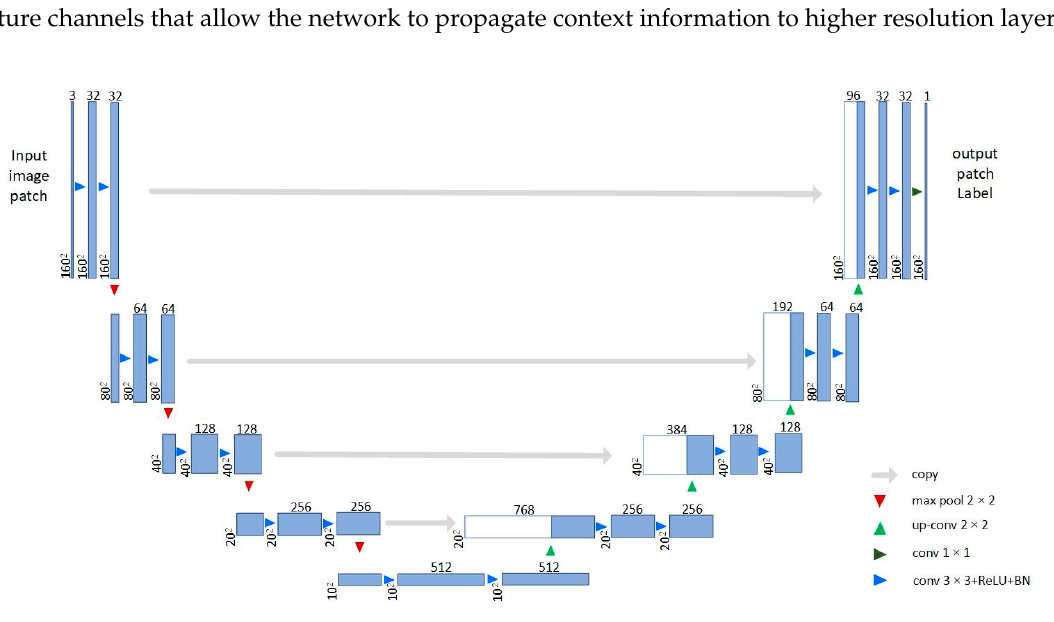
Figure 2. U-net architecture. Each blue box corresponds to a multi-channel feature map. The number of channels is denoted on top of the box. The x-y-size is provided at the lower left edge of the box. White boxes represent copied feature maps. The arrows denote the different operations.